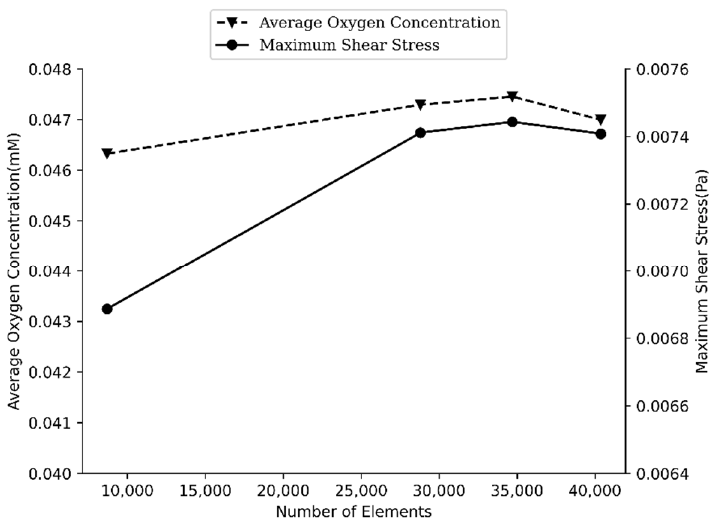
Figure 2. Mesh study graph for laminar flow and mass transport equations. As the grid size reduced in a step-by-step manner, both maximum shear stress and average oxygen concentration tend to be constant and independent of the number of the grids.